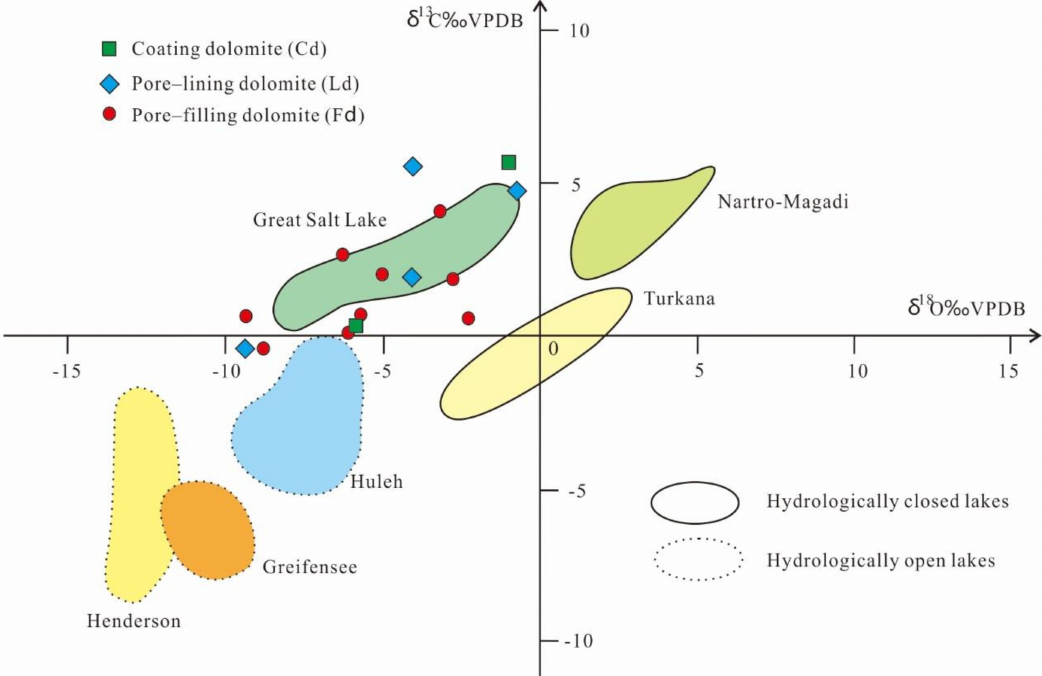
Figure 5. Carbon and oxygen isotopic compositions of different types of dolomite and sedimentary environments of the Paleogene Shahejie Formation in the Shijiutuo area, Bohai area